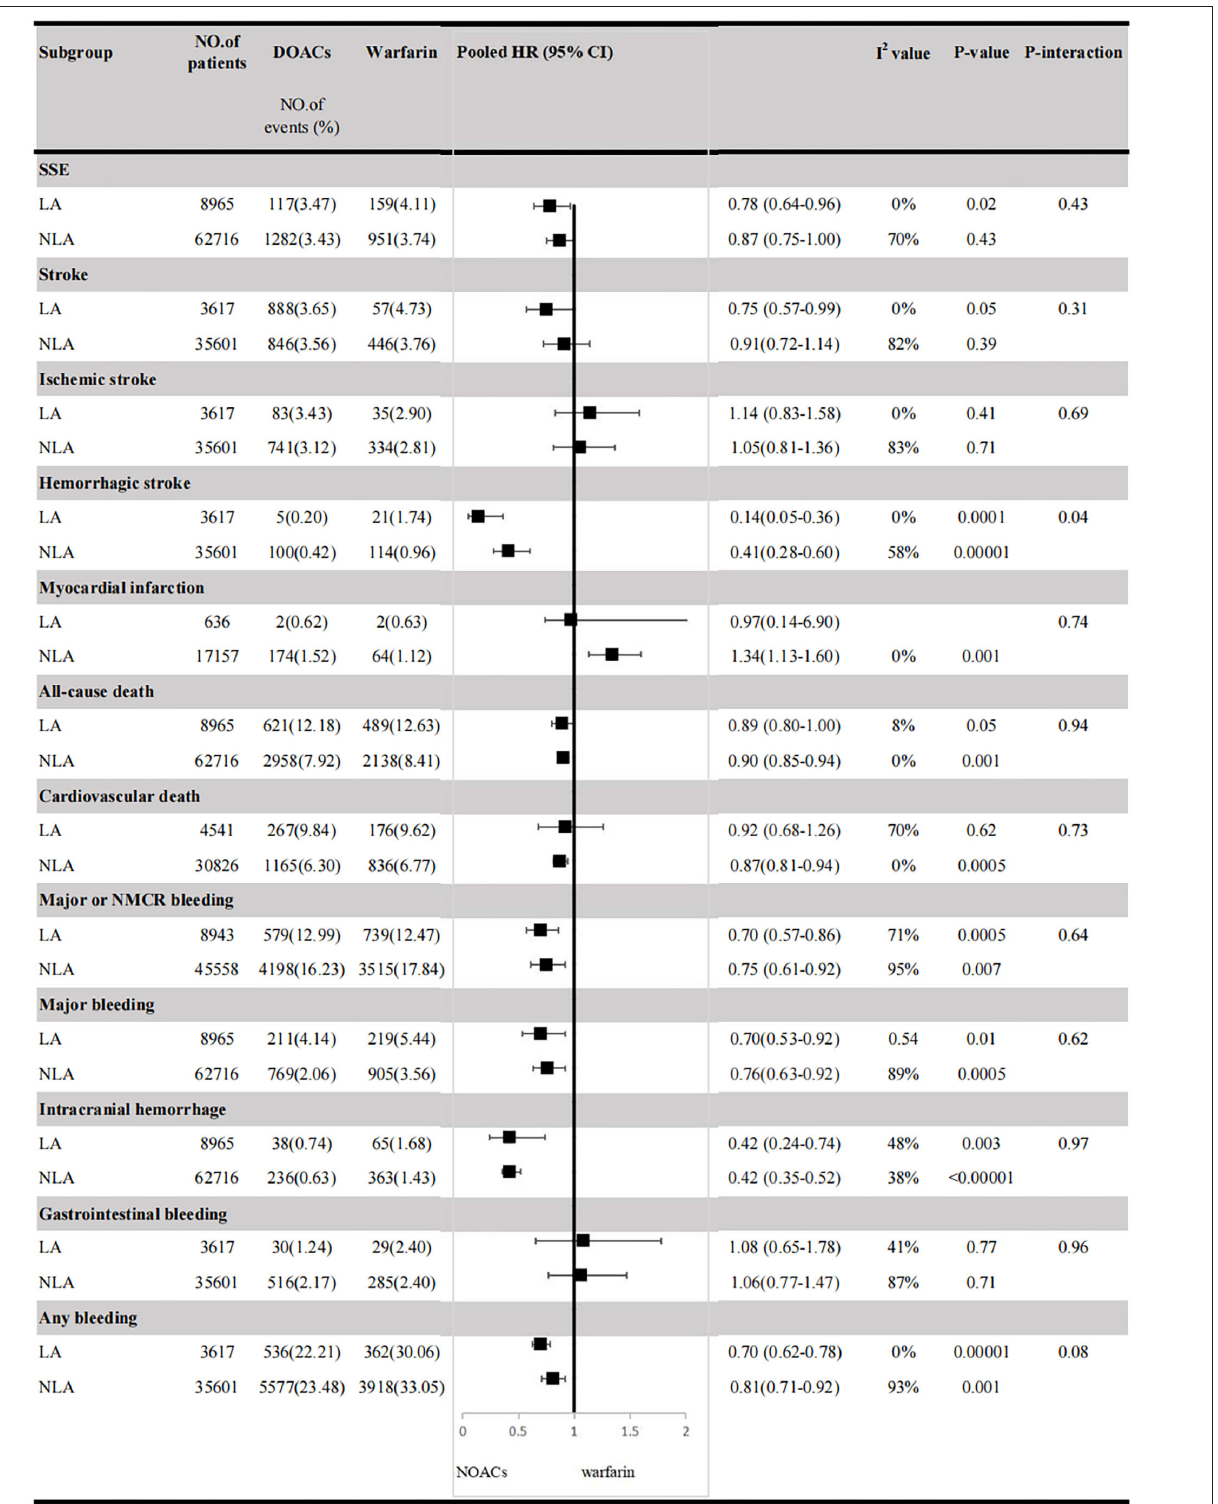
FIGURE 5 | Efficacy and safety outcomes in AF patients from Latin American and non-Latin American. SSE, stroke or systemic embolism; CI, confidence interval; HR, hazard ratio; LA, Latin American; NLA, non-Latin American; CI, confidence interval; major or NMCR bleeding, major or non-major clinically relevant bleeding.